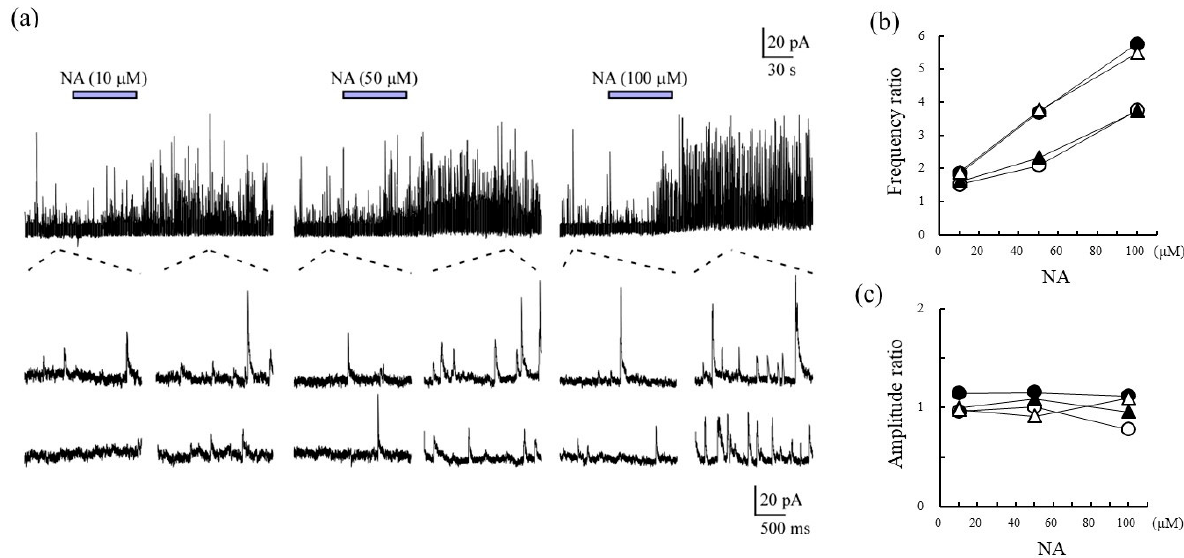
Figure 1. The effects of noradrenaline (NA; 10–100 µ M) on spontaneous inhibitory postsynaptic currents (sIPSCs) in substantia gelatinosa (SG) neurons from the spinal cords of rats. A typical trace from a single SG neuron is presented ( a ). The ratios of frequency ( b ) and amplitude ( c ) were plotted against a series of concentrations for each SG neuron. The fre- quency/amplitude ratio represented the response before drug application compared with the response following application of the drug. The responses of each NG neuron are revealed as circles and triangles with open and closed. The same symbol means the same SG neuron.